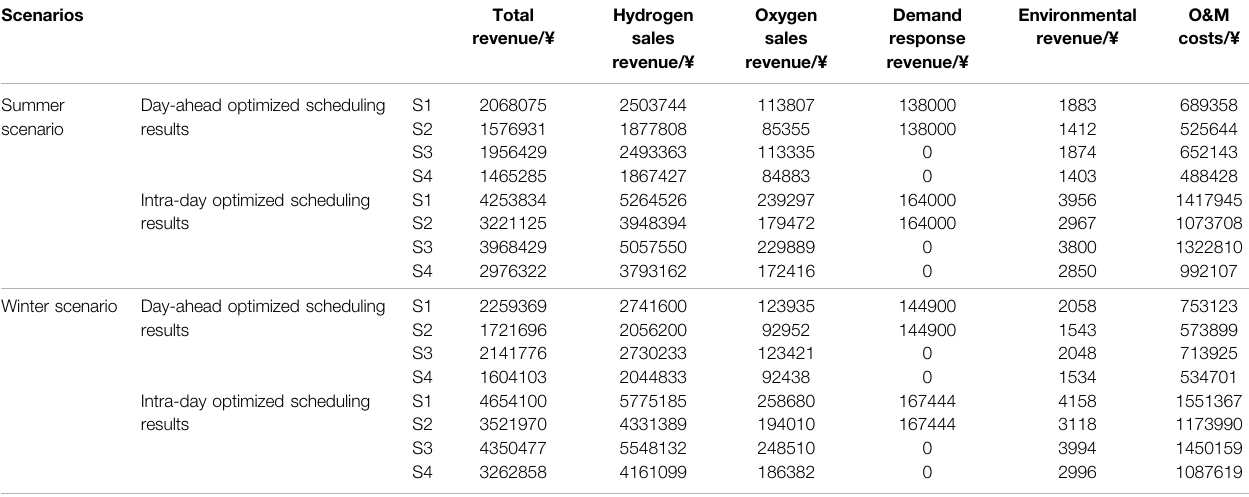
TABLE 3 | Microgrid revenue of typical day in